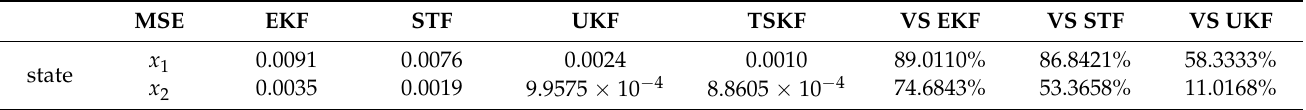
Table 3. Performance comparison of different algorithms.